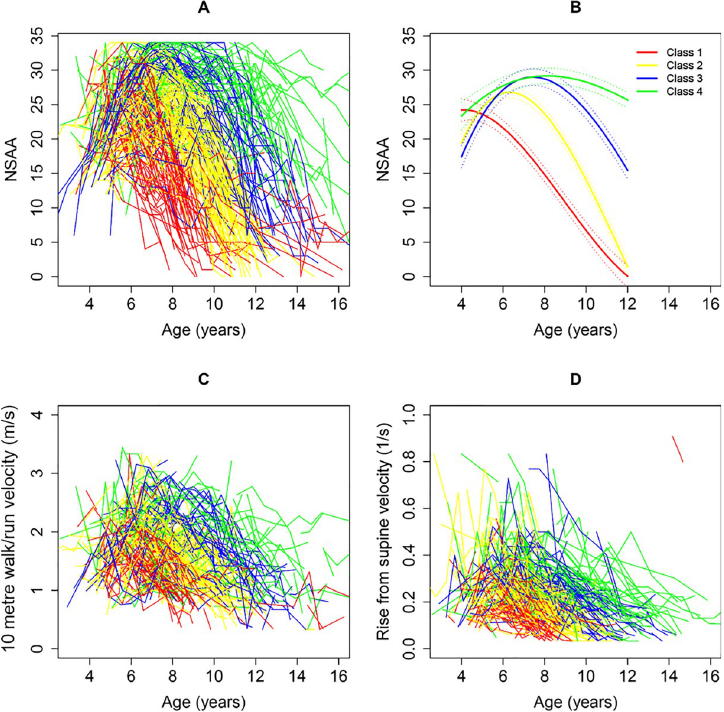
Fig 3. Individual patient (A) and fitted mean (B) trajectories of NSAA total score by latent class; individual patient trajectories of (C) 10 metre walk/run velocity and (D) velocity of timed rise from supine, all stratified by latent class. m/s, metres per second; NSAA, North Star Ambulatory Assessment; s,